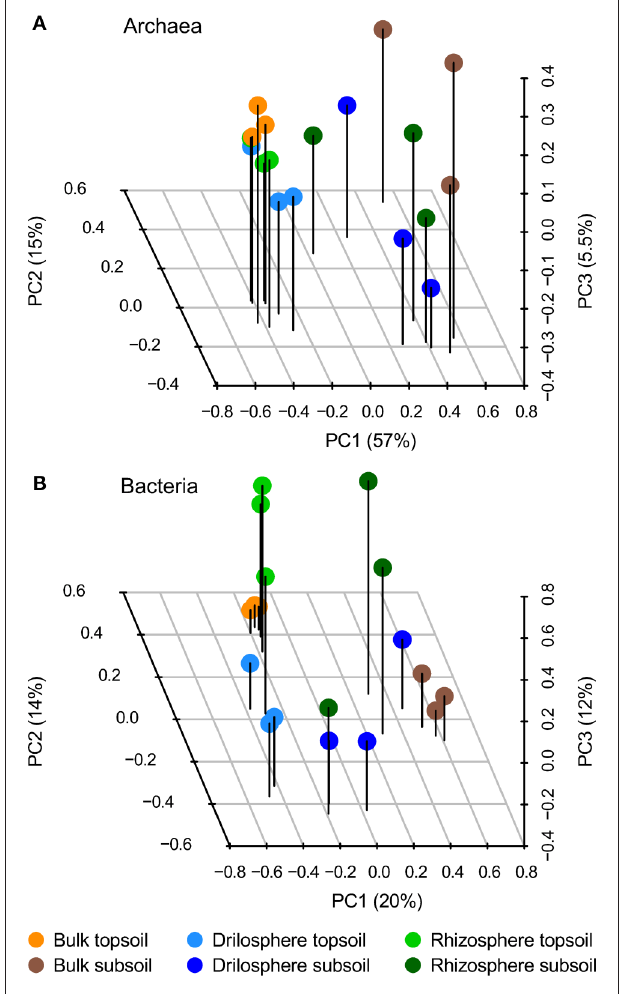
FIGURE 2 | Principal component analysis (PCA) of archaeal (A) and bacterial (B) OTUs based on 16S rRNA gene amplicons at 95% similarity level. The first three components from the PCA of relative, Hellinger-transformed data are